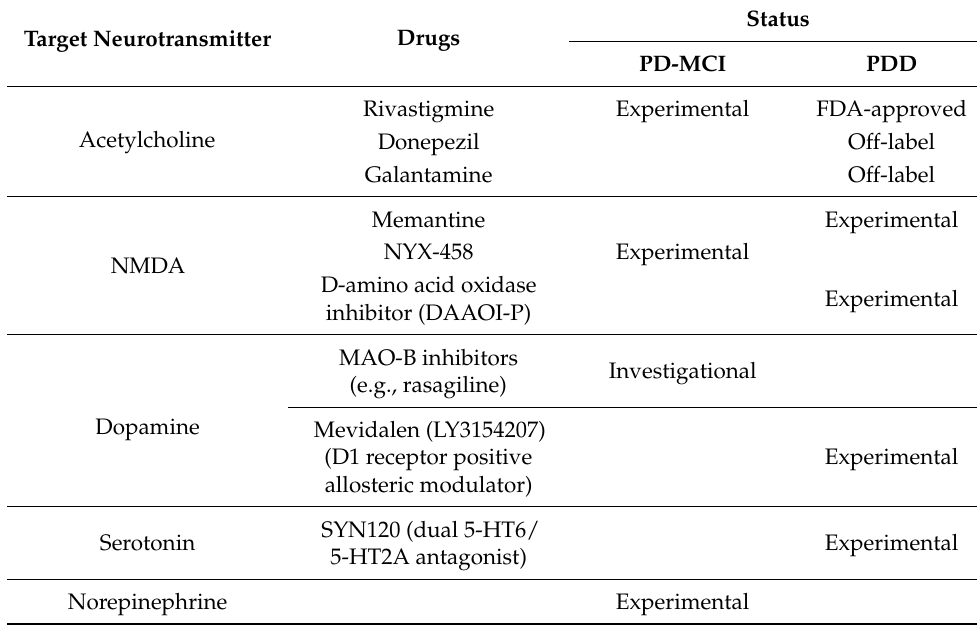
Neurotransmitters targeted for pharmacologic treatments for Parkinson’s disease cognitive changes. Status Target Neurotransmitter Drugs PD-MCI PDD Rivastigmine Experimental FDA-approved Acetylcholine Donepezil Off-label